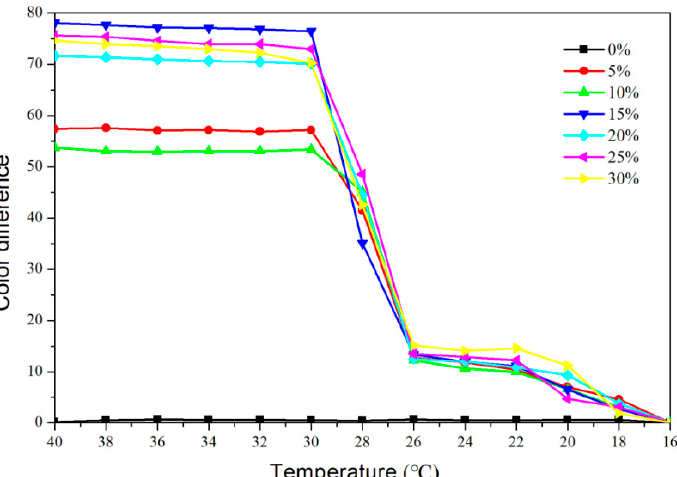
Figure 4. The color difference of topcoats with fluorane microcapsules during the cooling process (40–16 °C).